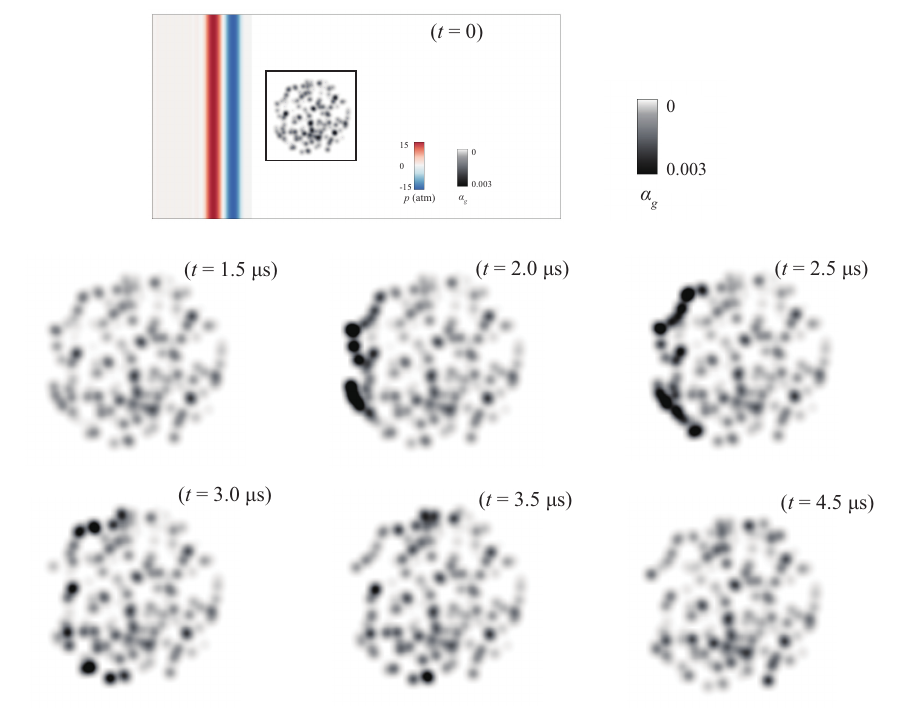
Figure 11. The gas volume fraction α g when the bubble cluster interacts with a sinusoidal pulse at 1.5 µ s, 2.0 µ s, 2.5 µ s, 3.0 µ s, 3.5 µ s, and 4.5 µ s.